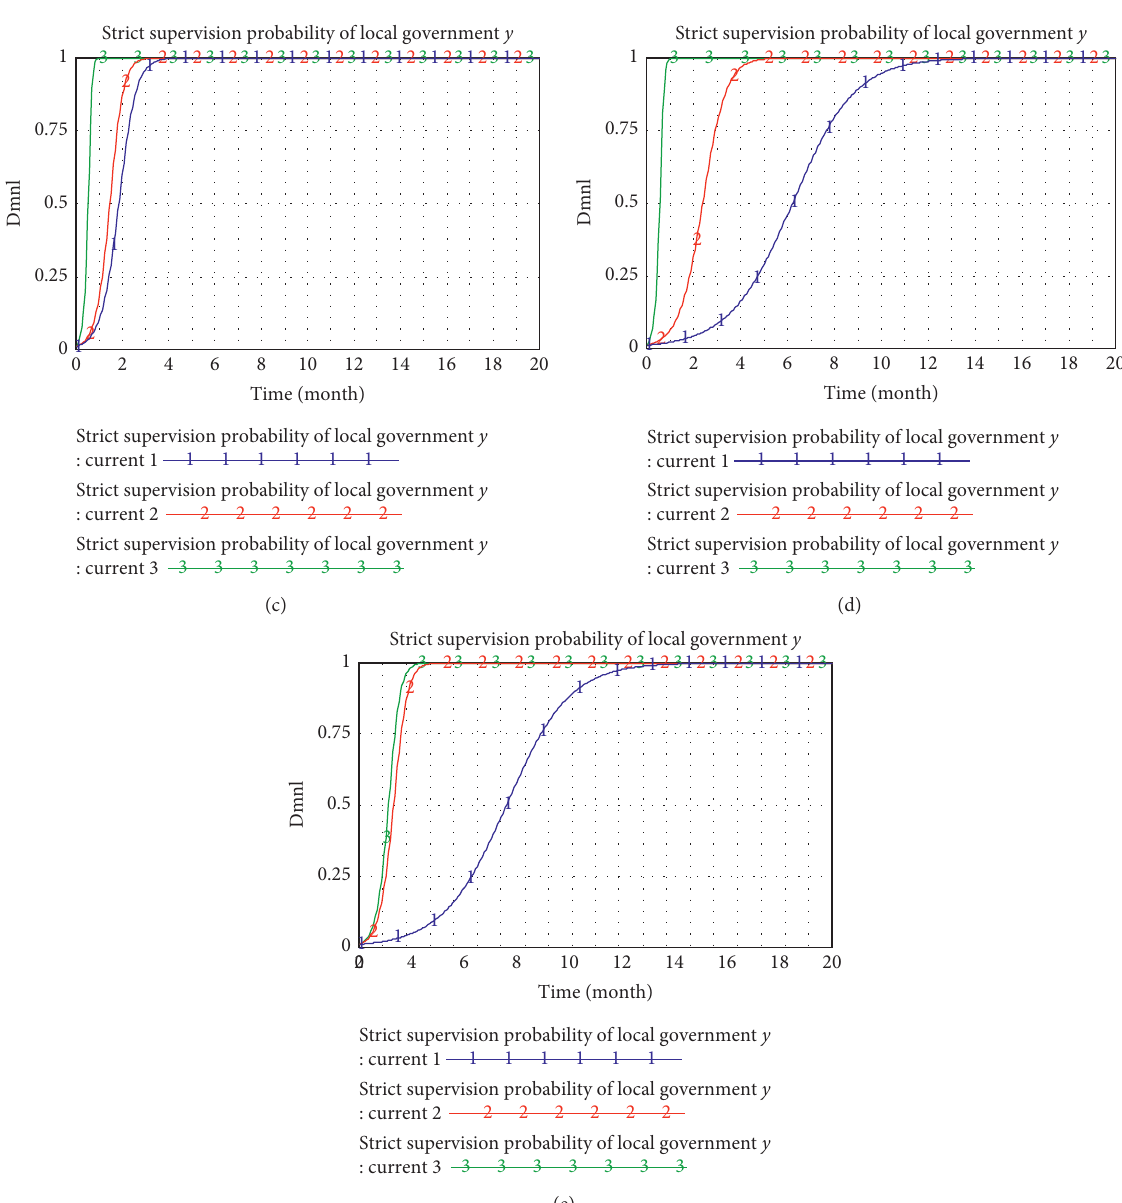
Figure 13: The impact of external variables on the strategic choice of local government: (a) Current 1: C 3: C 1 � 9; (b) Current 1: C 2 � 3, Current 2: C 2 � 5, and Current 3: C 2 � 7; (c) Current 1 A 1 � 2, Current 2 : A 1 � 4, and Current 3: A 1 �� 6;